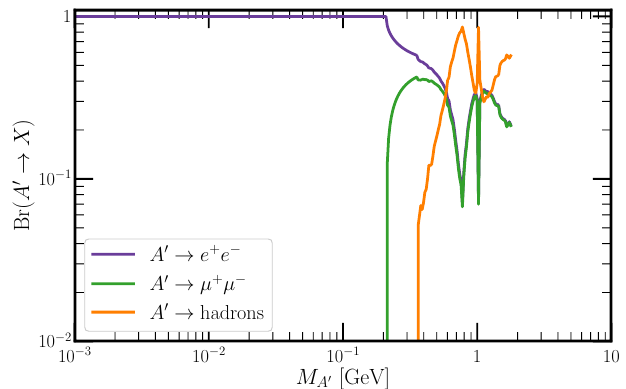
Figure 6 . The branching ratio of the dark photon A 0 into di(cid:11)erent (cid:12)nal states of interest as a function of mass M A 0 : A 0 e + e (cid:0) (purple), (cid:22) + (cid:22) (cid:0) (green), and hadronic (cid:12)nal states (orange). ! Adapted from ref.